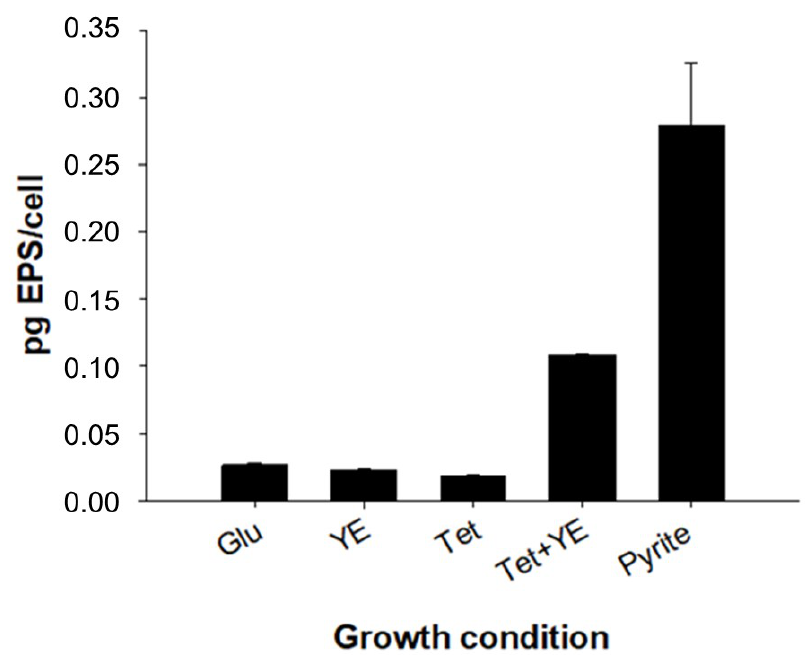
Figure 3. Comparison of capsular EPS produced per cell of A. copahuensis cells cultured in different growth conditions: glucose (Glu), yeast extract (YE), tetrathionate (Tet), tetrathionate and yeast extract (Tet + YE), and pyrite. Error bars show standard deviation from two independent experiments (n = 2).